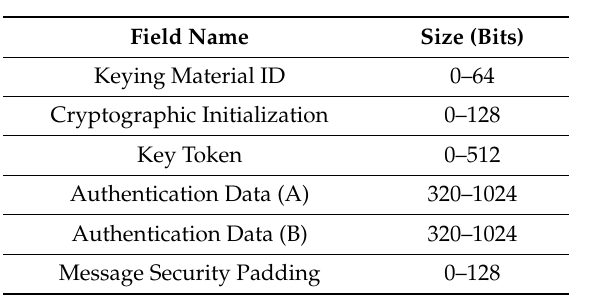
Table 2. Typical SPI field